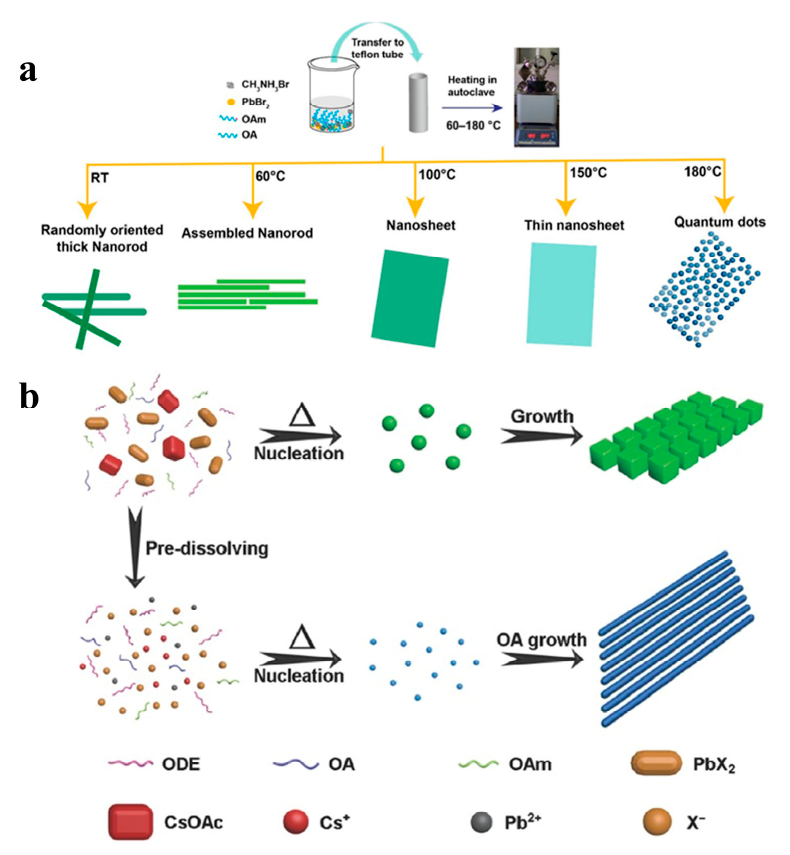
Figure 8. ( a ) Schematic diagram of the synthesis procedure of MAPbBr 3 nanostructures and their structural evolution with different reaction temperatures. Reproduced with permission from refer‑ ence [85]. Copyright 2020, American Chemical Society. ( b ) Proposed growth process of CsPbBr 3 NCs obtained without and with precursor dissolving. Reproduced with permission from reference [84].